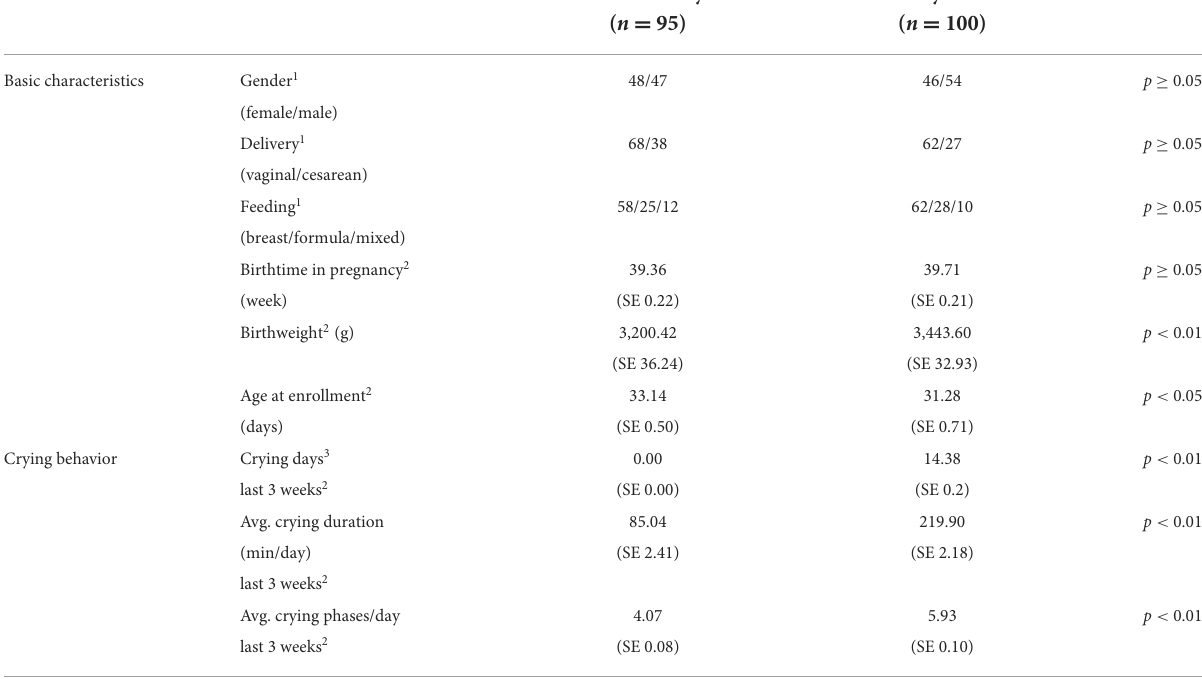
TABLE 1 Baseline characteristics of non-colicky and colicky infant